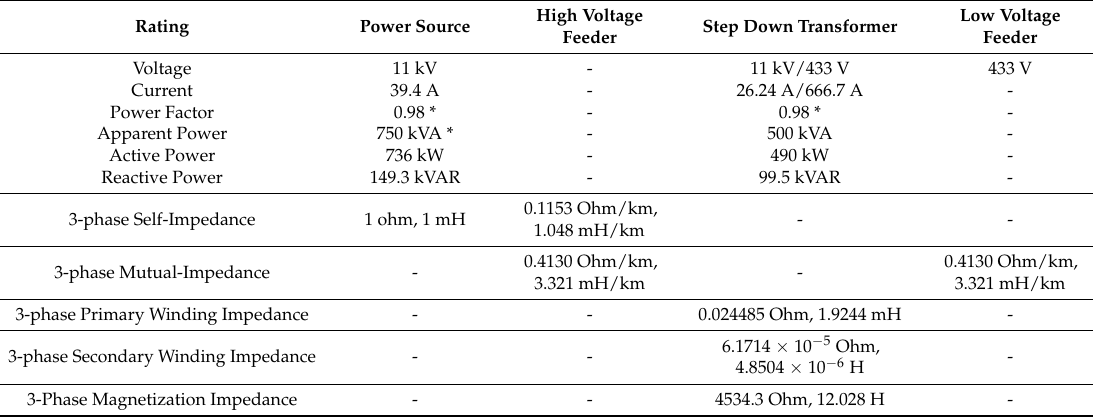
Table A2. Values of the parameters, specifications and settings for the components of the Simulink model of power